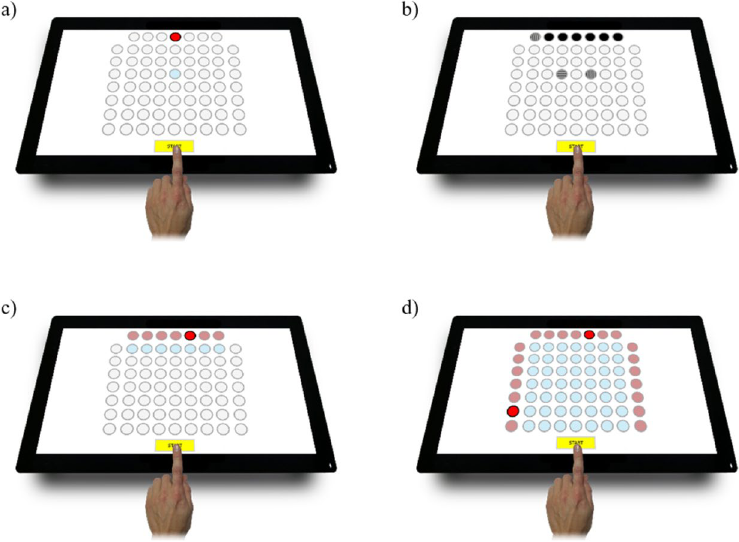
Figure 1. Reaction panel of the Test2Drive system; ( a ) SIRT, ( b ) CHORT, ( c ) HECOR, ( d ) SPANT 29